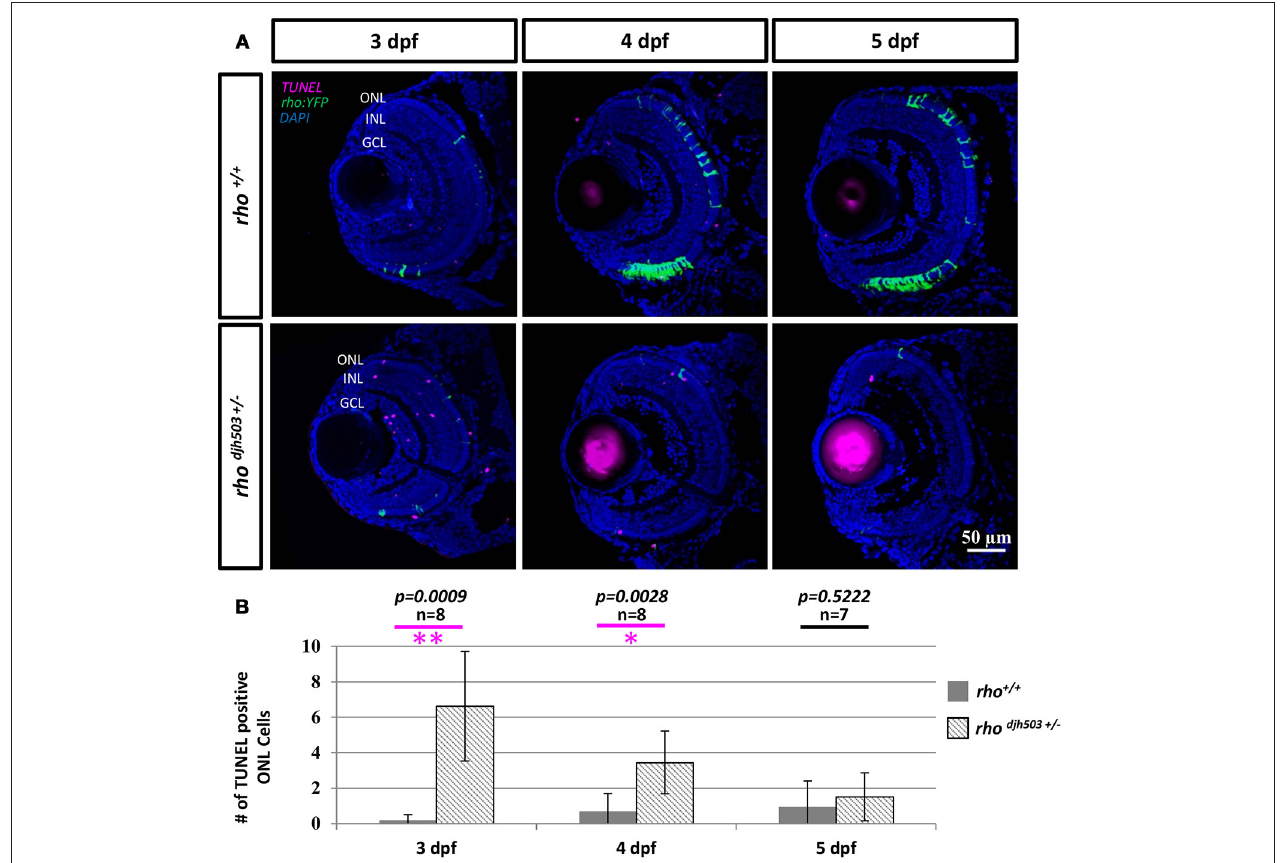
FIGURE 4 | The number of apoptotic cells in the ONL is increased in rho djh 503 c + / − mutant retinas at early developmental stages. (A) Representative images of TUNEL stained retinas from 3 to 5 dpf. In wildtype retinas, TUNEL positive cells (magenta) were rarely seen in the ONL from 3 to 5 dpf. In contrast, TUNEL positive cells were frequently detected in rho djh503 + / − mutants at 3 and 4 dpf, but only occasionally at 5 dpf. Rod cells are labeled by YFP (green). (B) Quantification of TUNEL positive cells in the ONL. The number of TUNEL positive cells was significantly higher in rho djh503 + / − mutants than in wildtype at 3 and 4 dpf, but not 5 dpf. Mann-Whitney test p -values: ** p < 0.001, * p < 0.01. Sample size (n) of each condition is provided. DAPI (blue) was used to stain nuclei. dpf, days post-fertilization; GCL, ganglion cell layer; INL, inner nuclear layer; ONL, outer nuclear layer; rho, rhodopsin ; TUNEL, terminal deoxynucleotidyl transferase dUTP nick-end